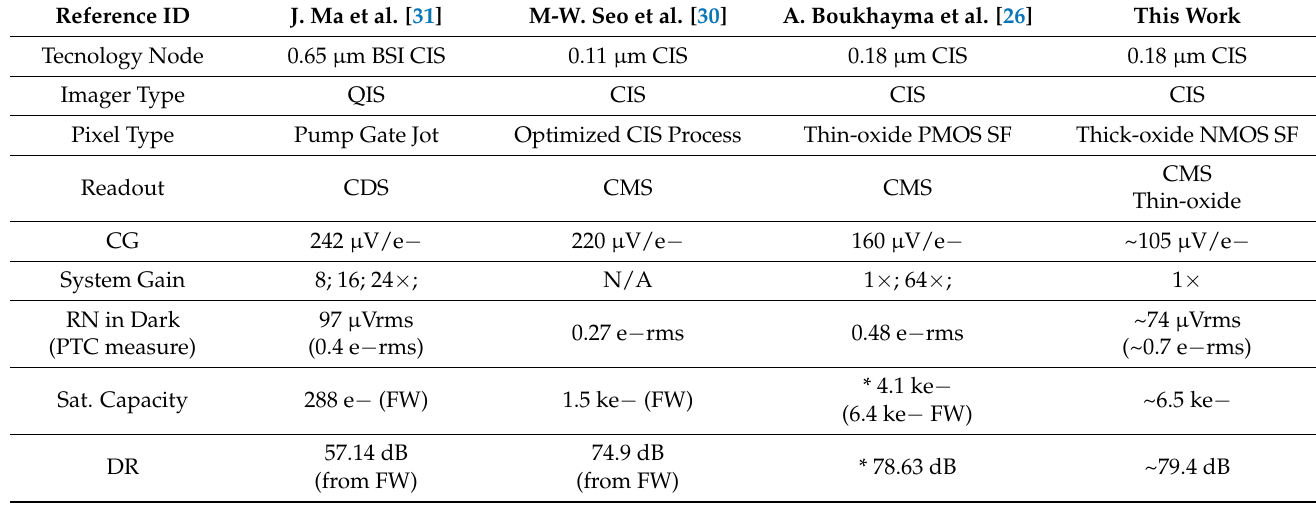
Table 3. Overall sensors